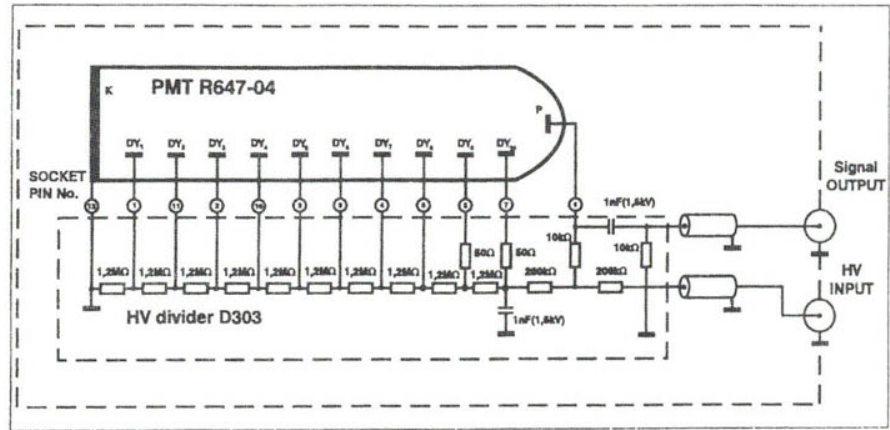
Fig. 2. A circuit-diagram of the D303 HV divider.